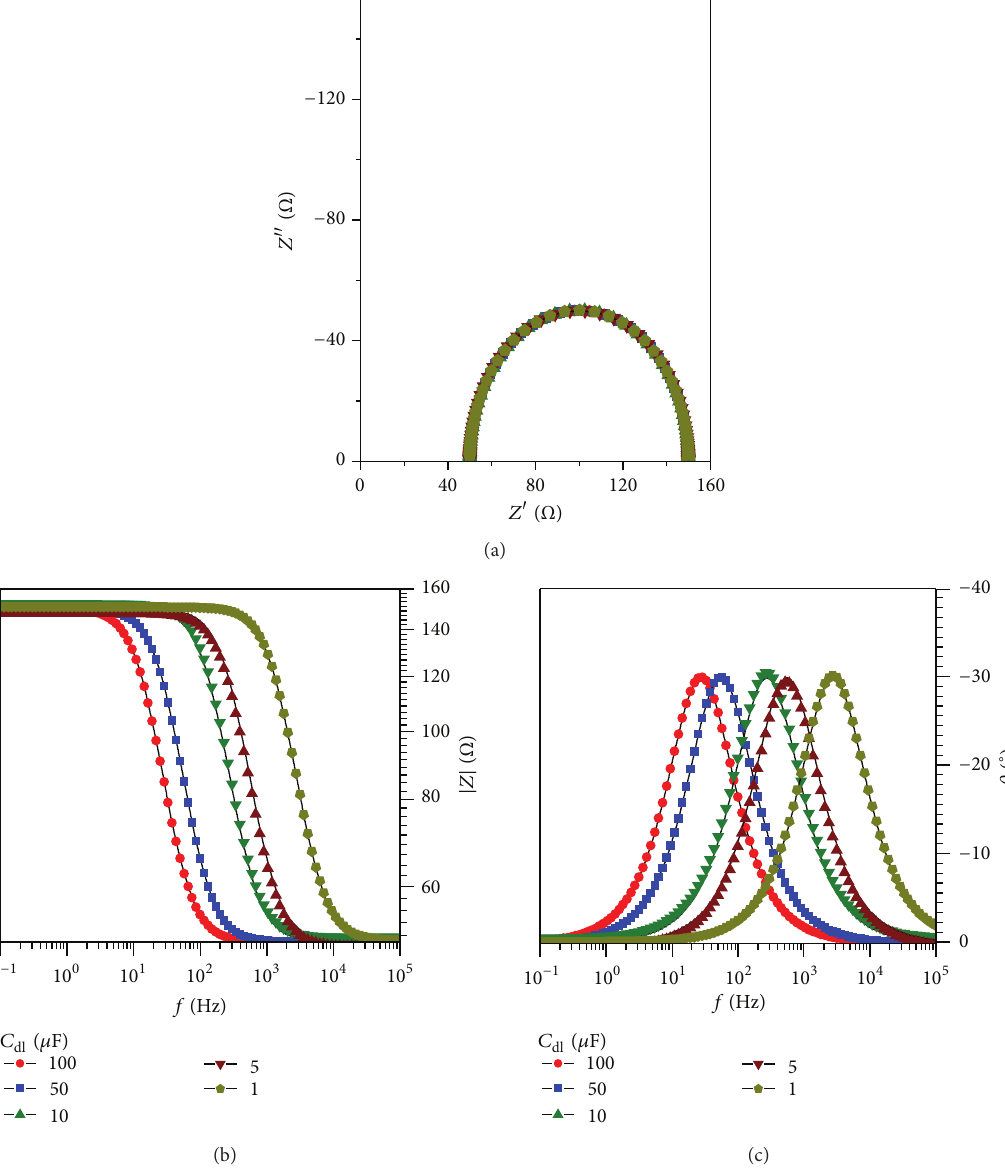
= 100 Ω and different ct